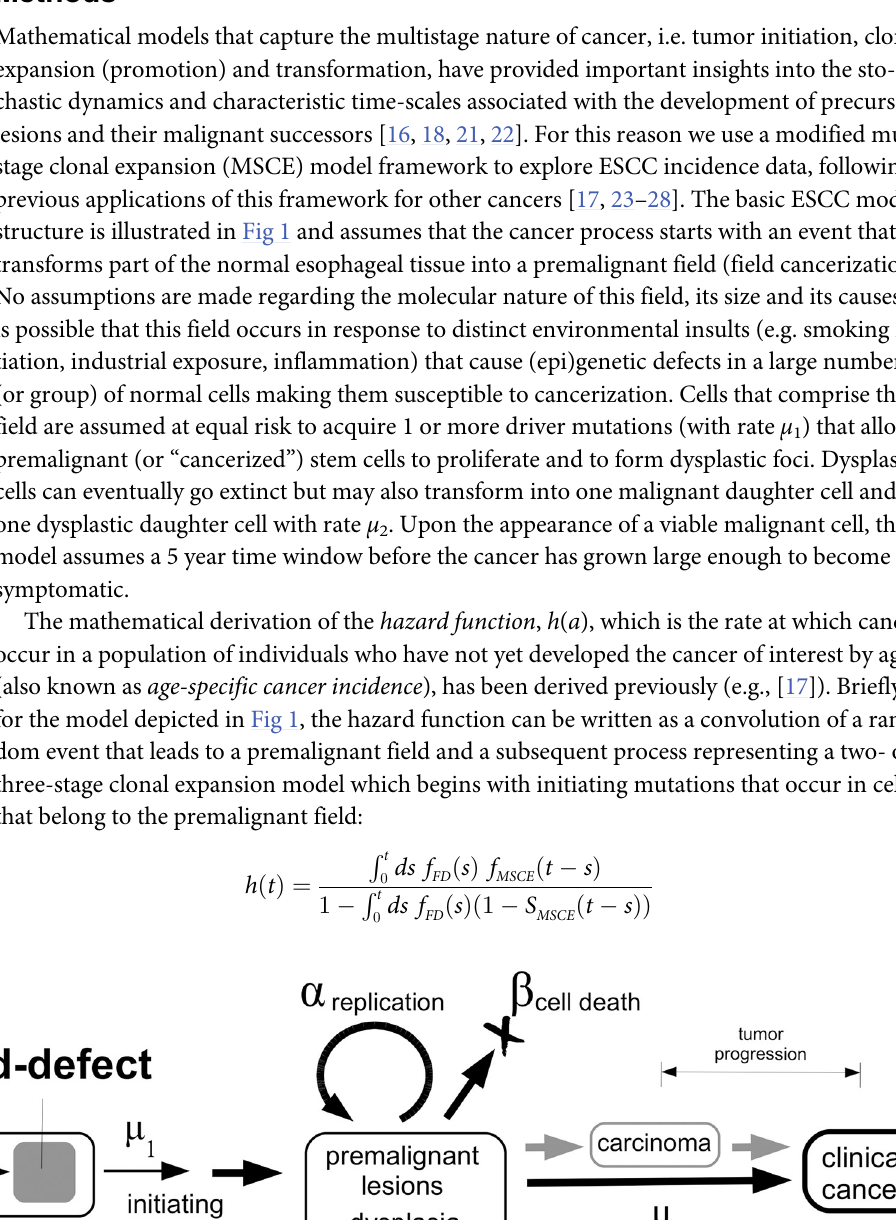
PLOS Computational Biology | https://doi.org/10.1371/journal.pcbi.1008961 May 3,